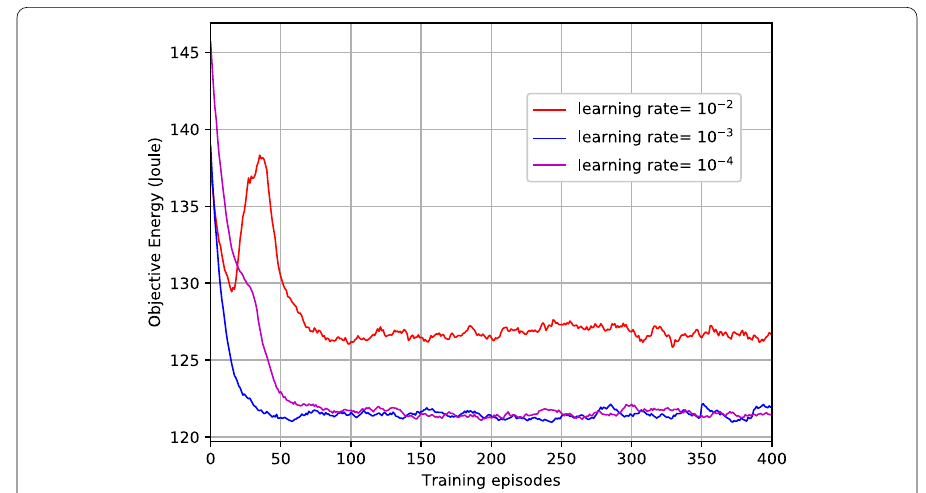
Fig. 7 Objective energy with different learning